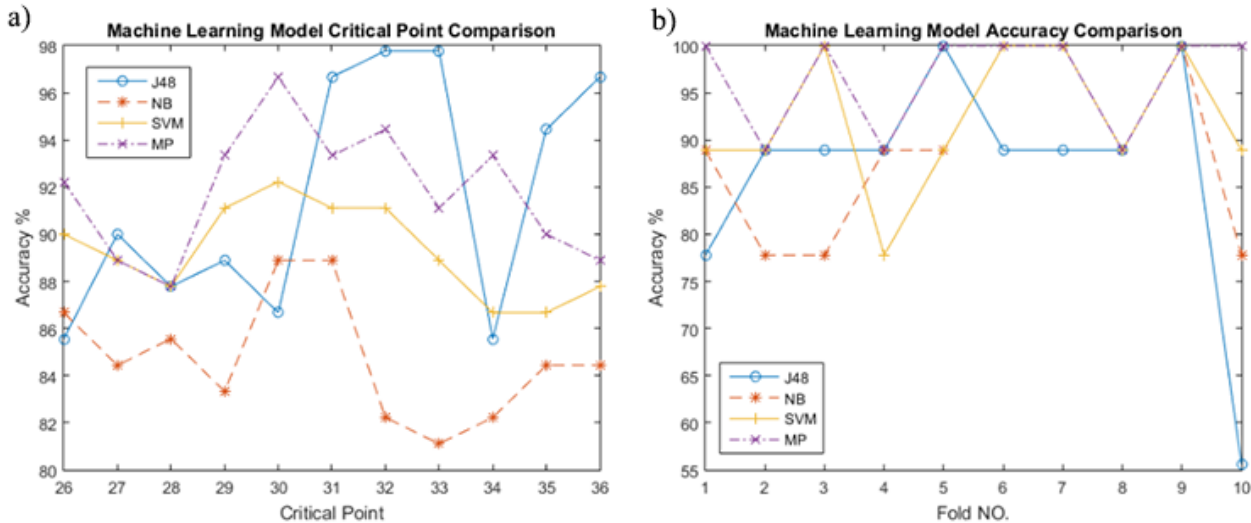
Figure 6. (a) Accuracy of each machine learning model with different critical points. (b) Evaluation of 10-fold cross-validation accuracy of each fold for different machine learning